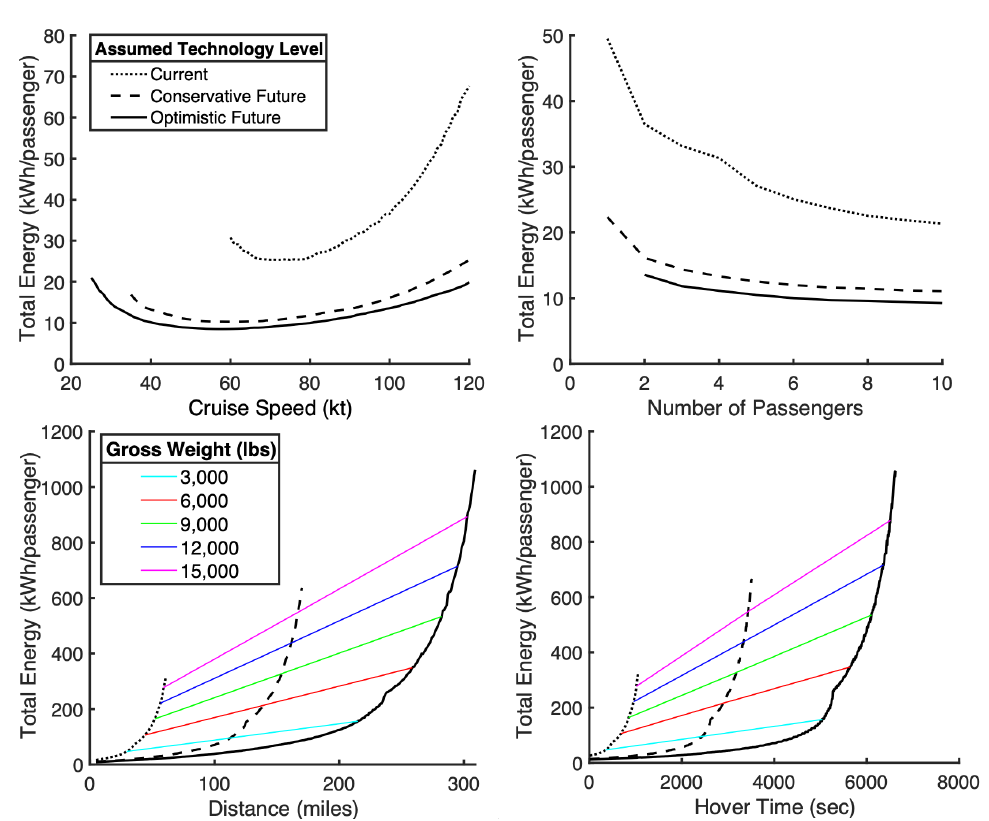
Figure 6. Total energy per passenger for a sweep of mission parameters with varying technology assumptions for a single-main-rotor